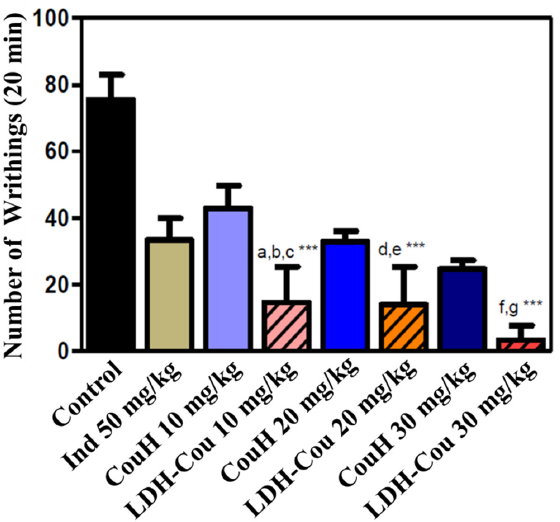
Figure 8. Acetic-acid test. Number of writhings in 20 min of experiment. a—LDH-Cou 10 mg/kg vs. Ind 50 mg/kg; b—LDH-Cou 10 mg/kg vs. CouH 10 mg/kg; c—LDH-Cou 10 mg/kg vs. CouH 20 mg/kg; d—LDH-Cou 20 mg/kg vs. Ind 50mg/kg; e—LDH-Cou 20 mg/kg vs. CouH 20 mg/kg; f—LDH-Cou 30 mg/kg vs. Ind 50mg/kg; g—LDH-Cou 30 mg/kg vs. CouH 30 mg/kg. *** p < 0.0001 (average ± SD, n = 7/group).